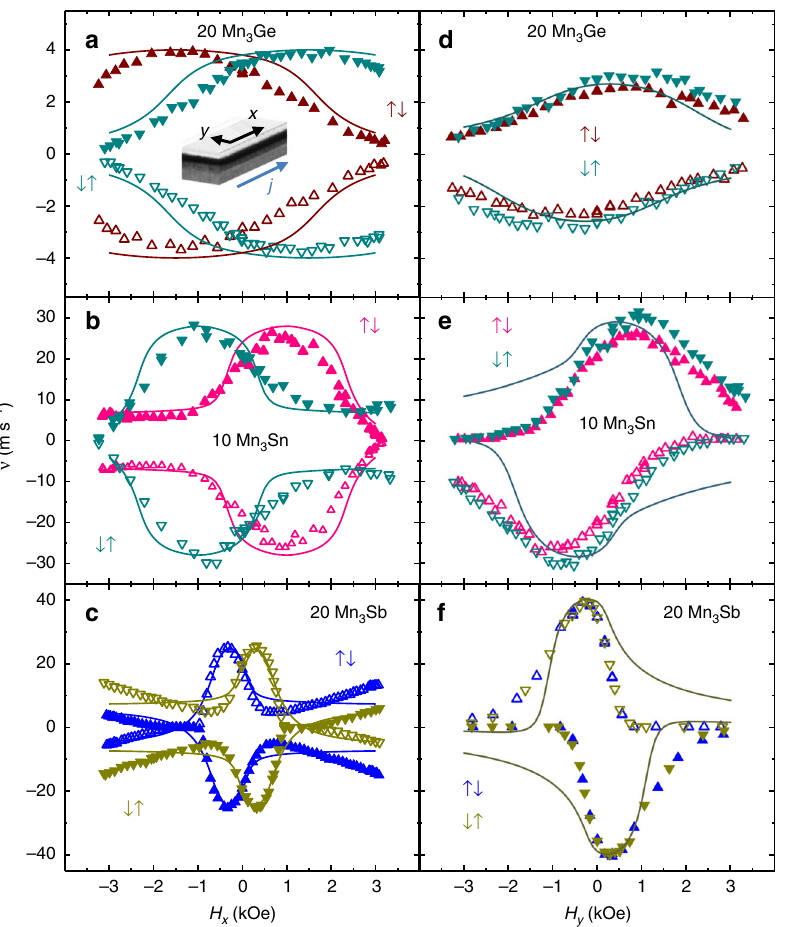
Fig. 4 DW velocity dependence on H x and H y . a – c ↑↓ and ↓↑ DW velocity dependence on longitudinally applied in-plane fi eld, H x , for 20 Å Mn 3 Ge, 10 Å Mn 3 Sn, 20 Å Mn 3 Sb nanowires with CoGa CTL. d – f ↑↓ and ↓↑ DW velocity dependence on laterally applied in-plane fi eld, H y , for the same nanowires. Positive H x and j are along the + x direction, positive H y is along + y as shown in the schematic included in a . Closed and open symbols represent positive and negative applied currents, respectively. Solid lines represent the 1D model simulation. Note that for the H y fi eld dependence, the simulated values for ↑↓ and ↓↑ DW con fi gurations overlap. The current densities, J , used for these measurements are: ( a ) 4 : 7 ´ 10 7 , ( b ) 8 : 5 ´ 10 7 , ( c ) 3 : 1 ´ 10 7 , ( d ) 4 : 3 ´ 10 7 , ( e ) 8 : 6 ´ 10 7 , and ( f ) 3 : 9 ´ 10 7 , all in A cm −